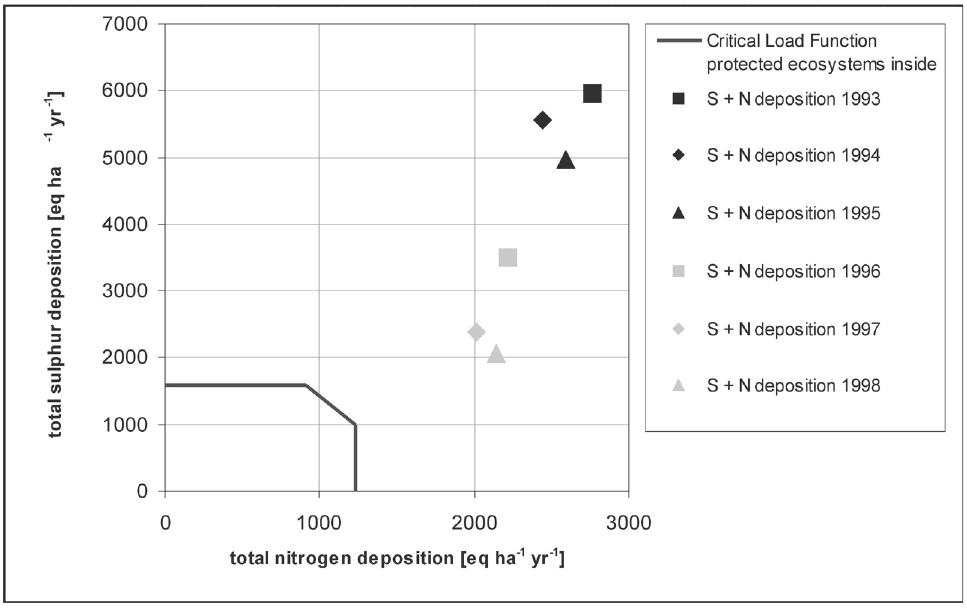
FIGURE 5 . Critical load function for a single German dataset